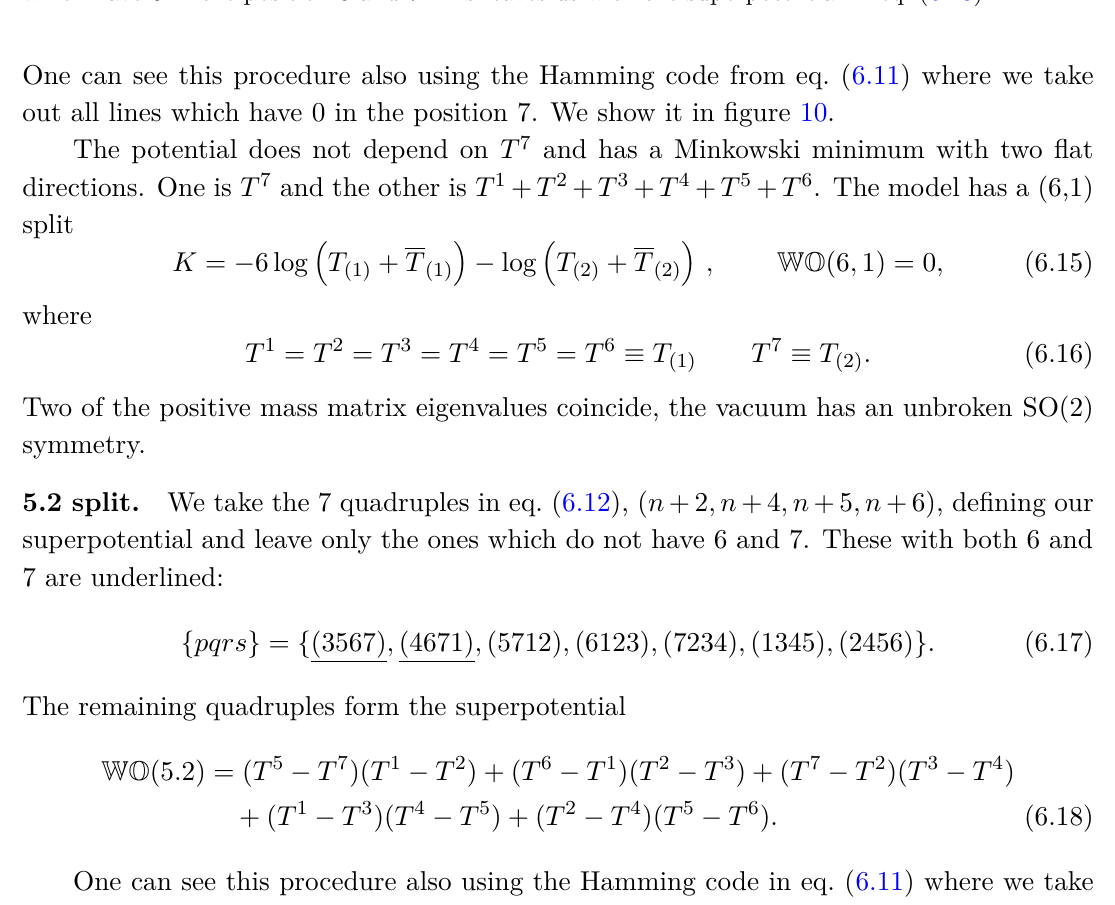
Figure 11 . We start with a cyclic Hamming code (7,4) in figure 5. We take out all codewords which have 0 in the position 6 and 7.This leaves us with the superpotential in eq.